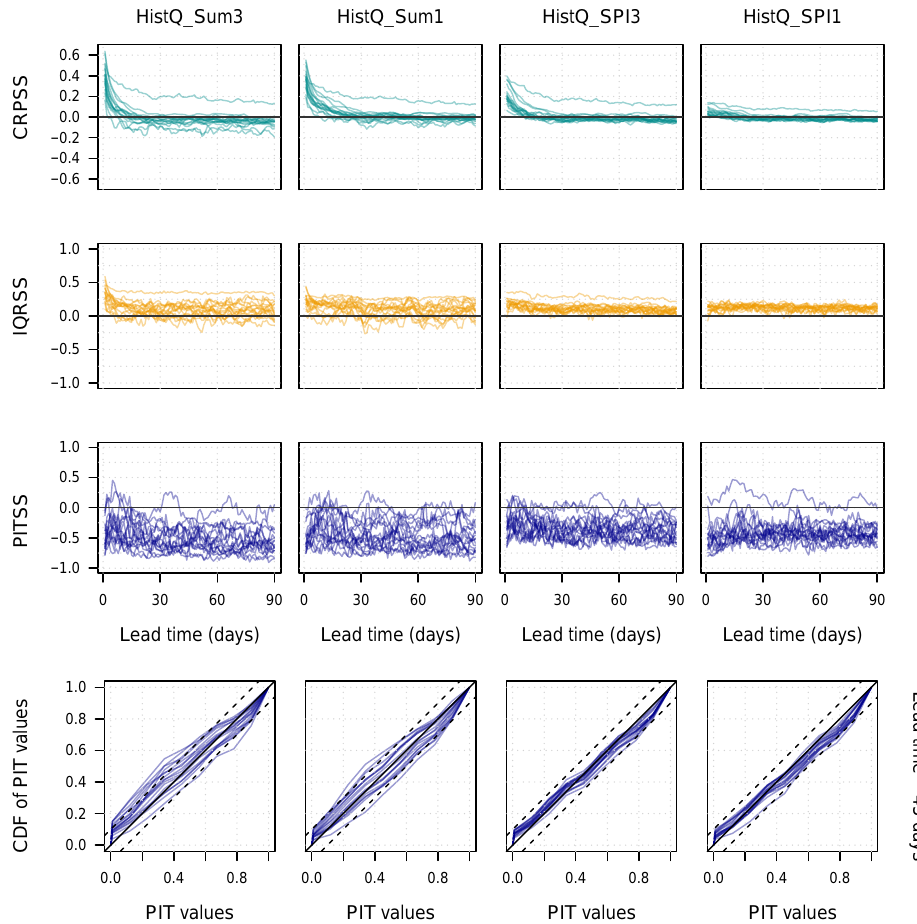
Figure 4. Skill scores (CRPSS, IQRSS, PITSS; first three rows) and PIT diagrams for a lead time of 45 days (last row) of the conditioned ensemble forecast scenarios: HistQ_Sum3, HistQ_Sum1, HistQ_SPI3 and HistQ_SPI1. In the skill scores, the reference forecast is the base ensemble HistQ. Each line represents one of the 16 catchments